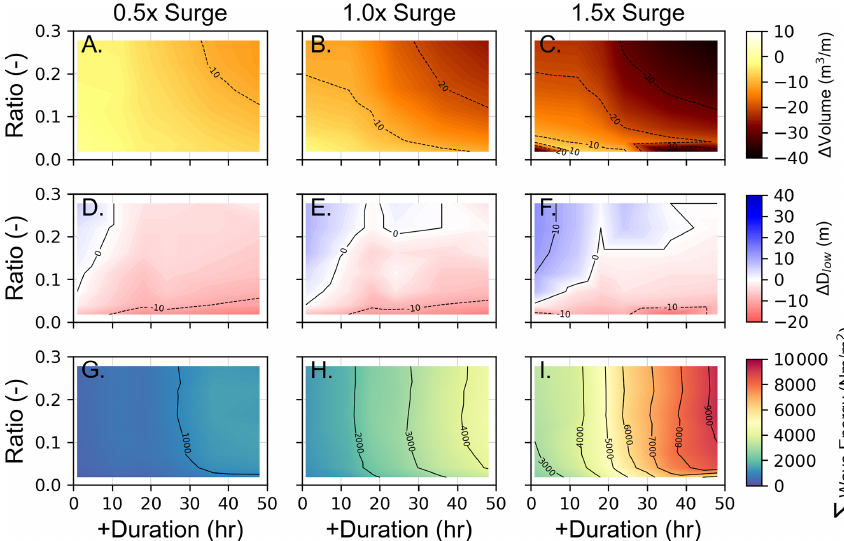
Figure 8. Dune erosion and wave impact energy for all toe-aligned simulations as a function of aspect ratio versus storm duration. Each column represents a different storm surge level (increasing left to right). The top row (a–c) shows the change in dune volume, the middle row (d–f) shows the change in dune toe position (negative values indicate landward erosion), and the bottom row (g–i) shows the cumulative wave energy impacting the